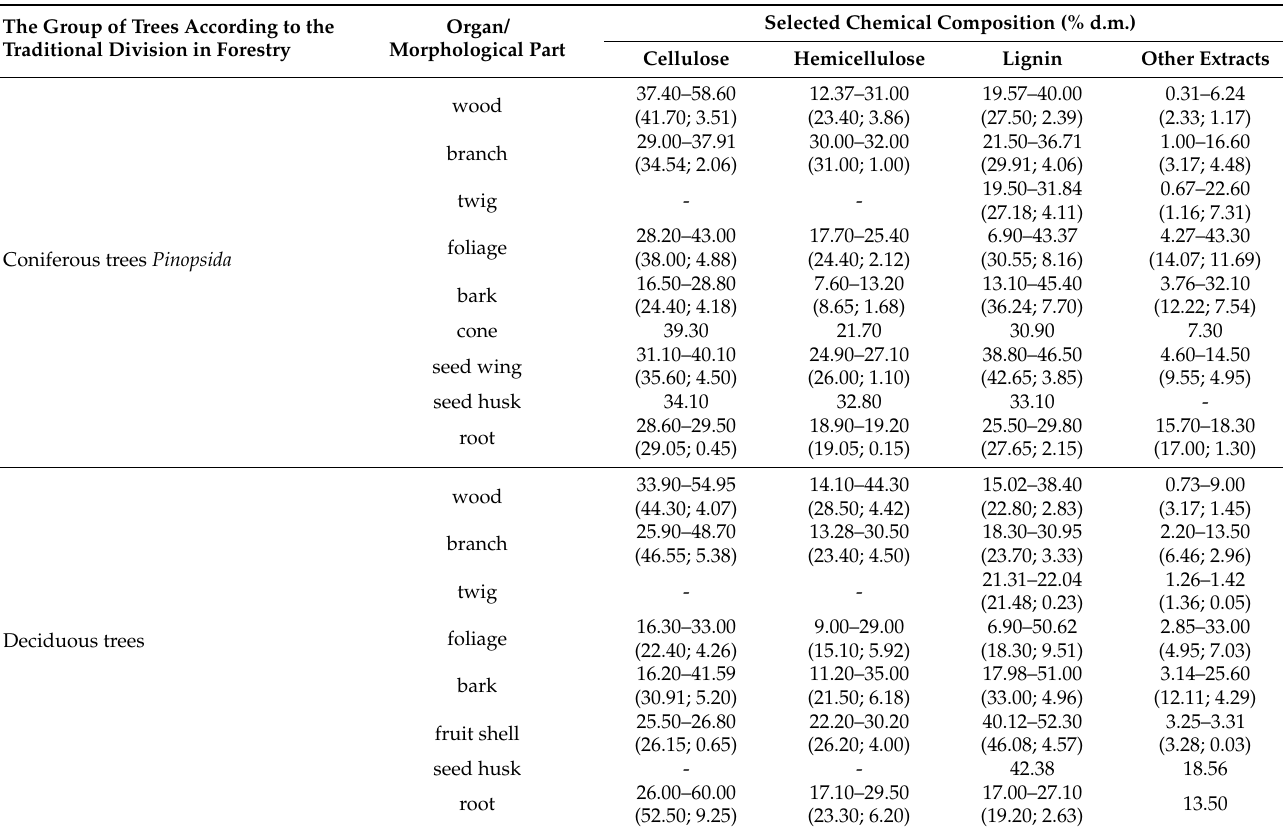
Table A6. Selected chemical composition of particular organs of coniferous and deciduous trees.